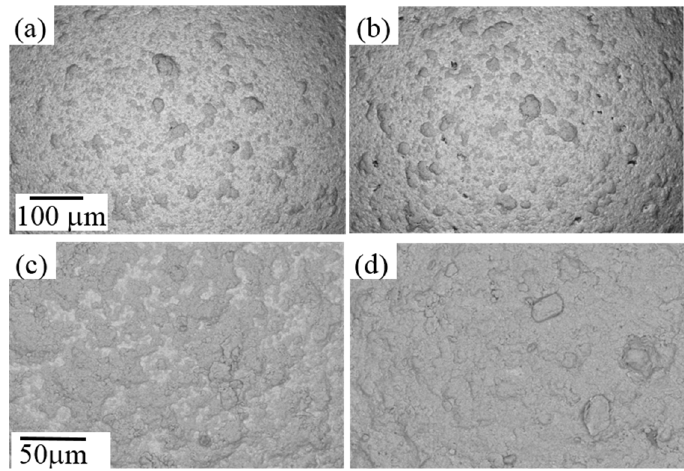
Figure 7. SEM images of morphologies of the samples: ( a ) TS300 ‐ 4; ( b ) TSS300 ‐ 4; ( c ) TS300 ‐ 8; and ( d ) TSY300 ‐ 8.